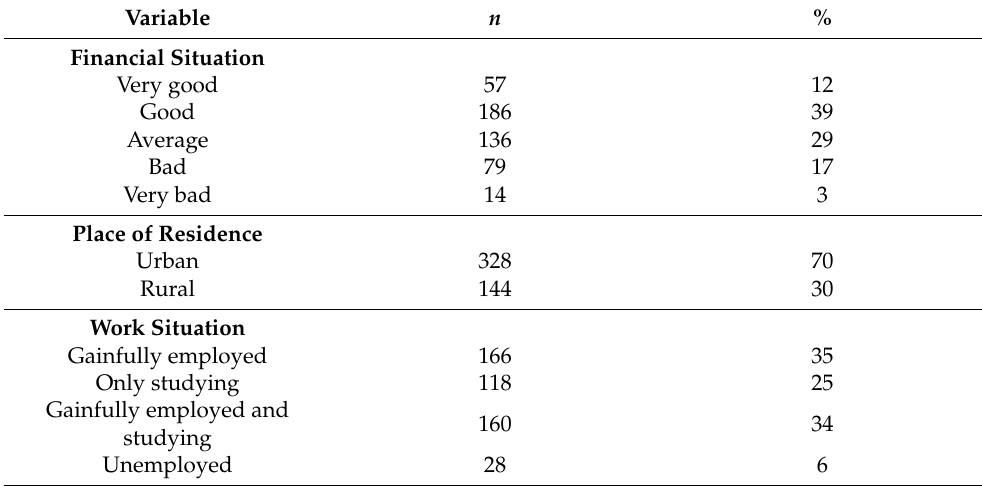
Table 1. Further demographic characteristics of the